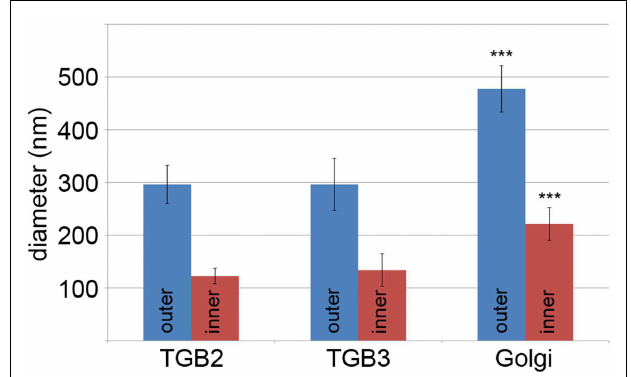
FIGURE 5 | Sizes ofTGB2 andTGB3 membrane hoops and trans -Golgi rings. Means with standard deviations are shown (TGB2: n = 8;TGB3: n = 21; Golgi: n = 17). Blue: outer diameter, red: inner diameter.TGB2 and TGB3 hoops outer and inner diameters, respectively, are not significantly different ( p > 0.05), but both outer and inner diameter of Golgi rings are significantly different from bothTGB2 andTGB3 ( p < 0.001) (see Appendix for results of statistical analysis).